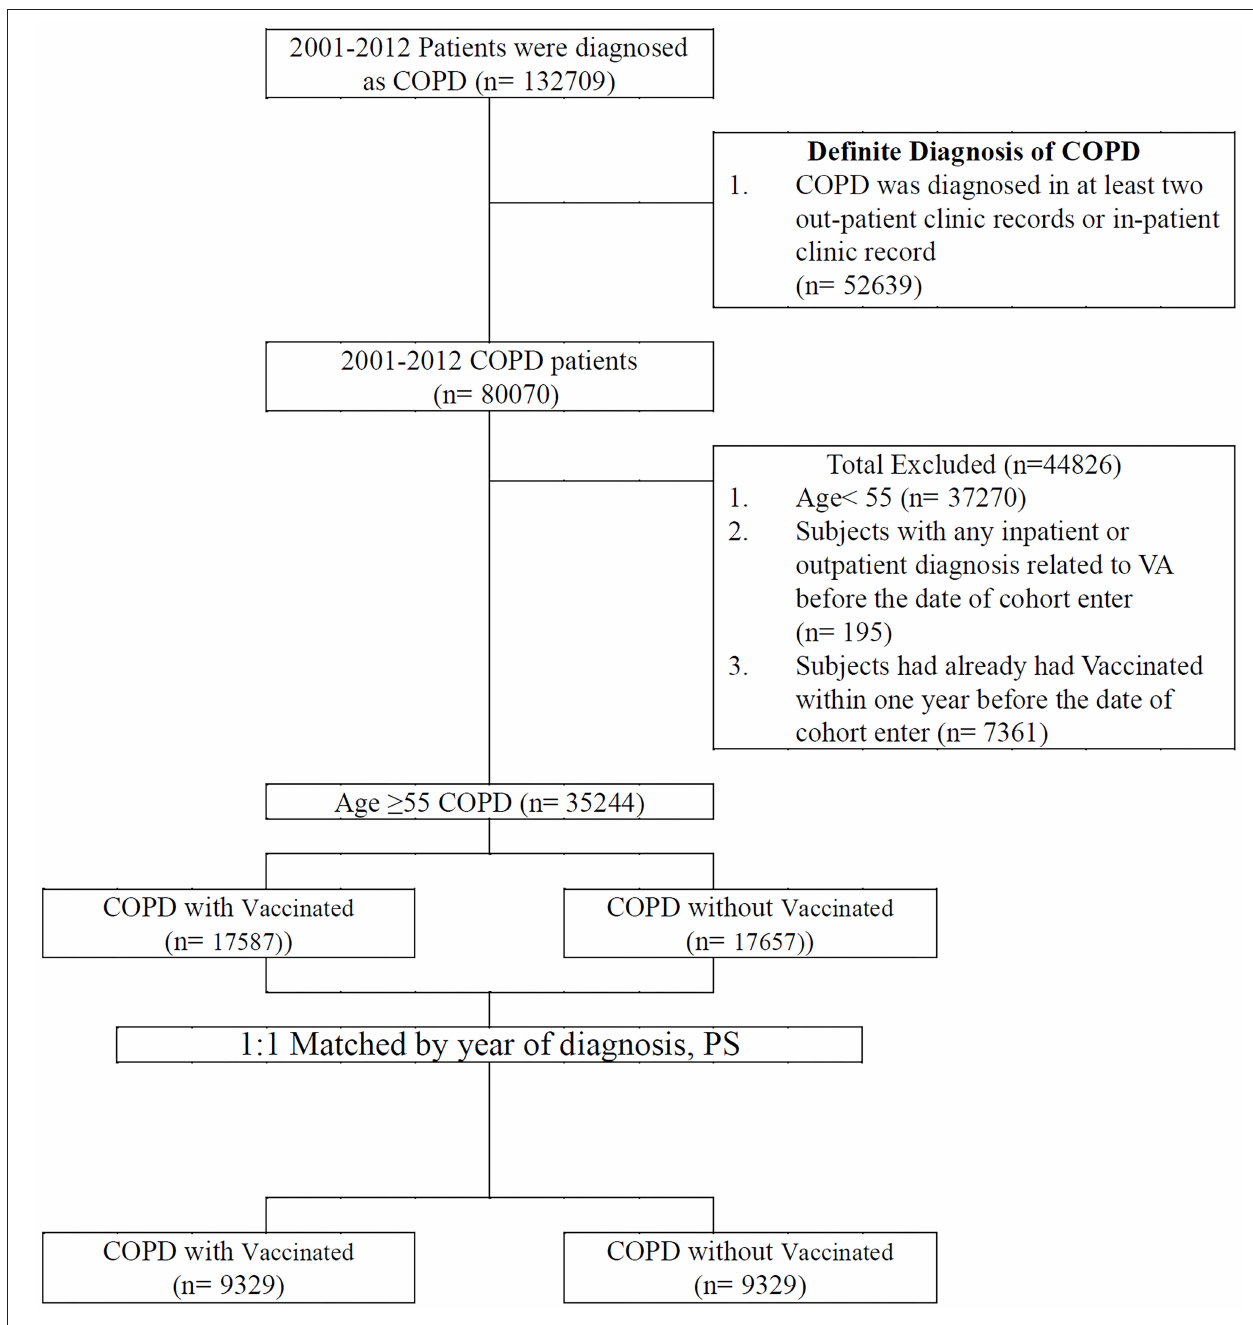
FIGURE 1 | Data selection